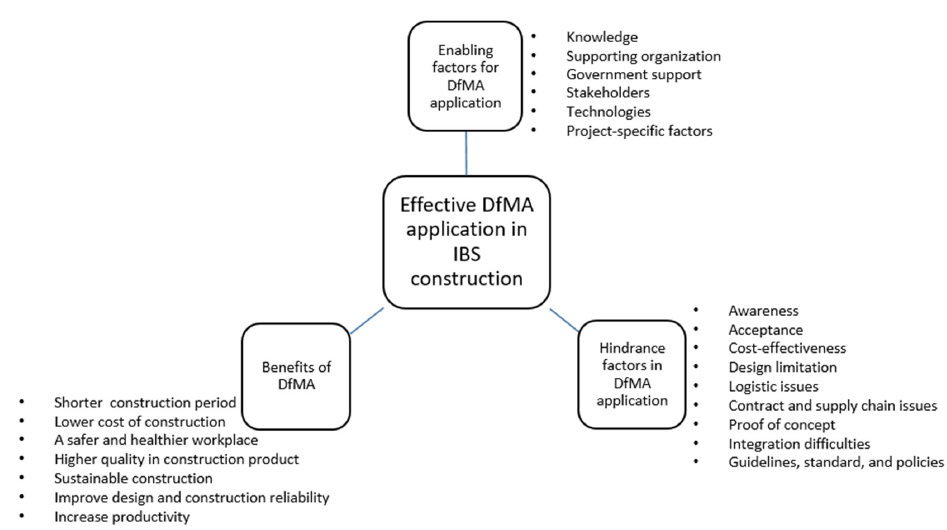
Figure 6. A conceptual framework for DfMA application. Table 5. Summary of research themes related to DfMA/prefabrication.